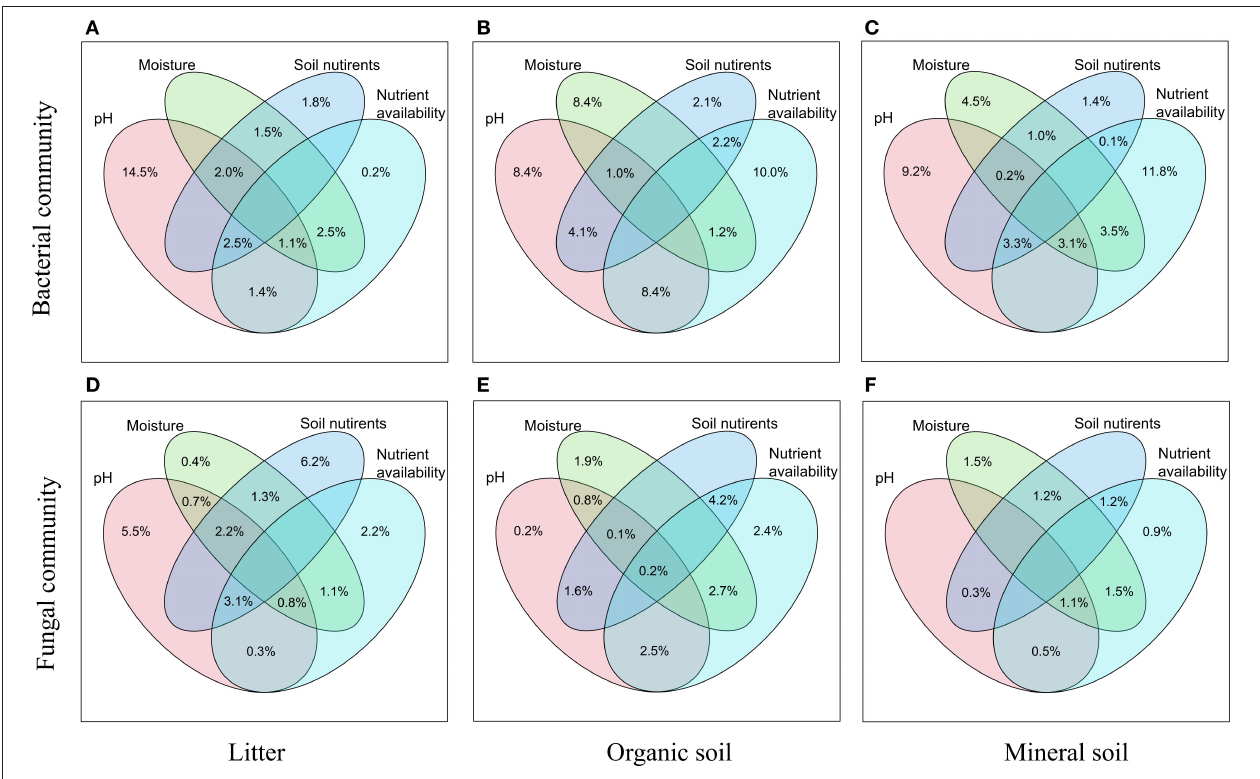
FIGURE 5 | Relative importance of different predictors of bacterial (A–C) and fungal (D–F) communities in different soil layers was revealed by RDA-based VPA analysis. Soil nutrients contain TC and TN, and nutrient availability contains DOC, DON, NH + 4 , NO − 3 , and AP.